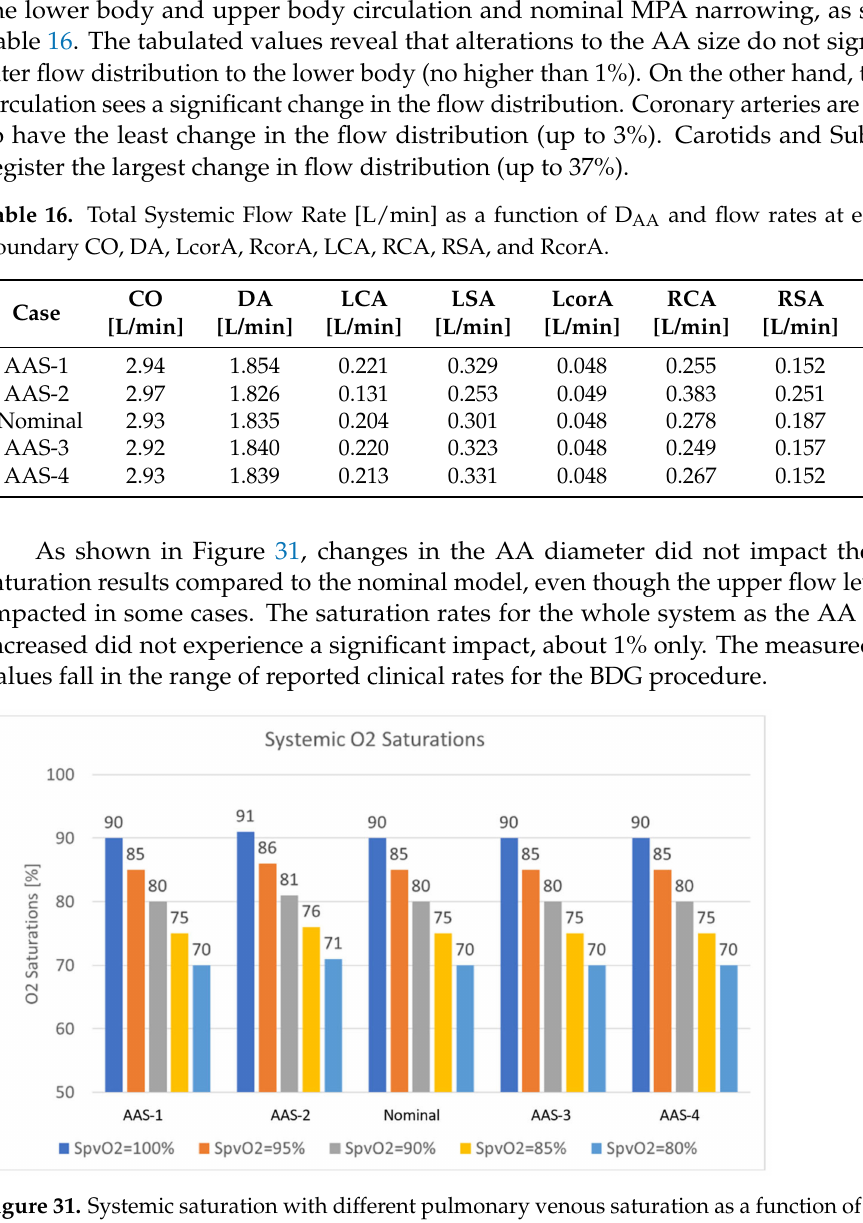
Figure 31. Systemic saturation with different pulmonary venous saturation as a function of aorta